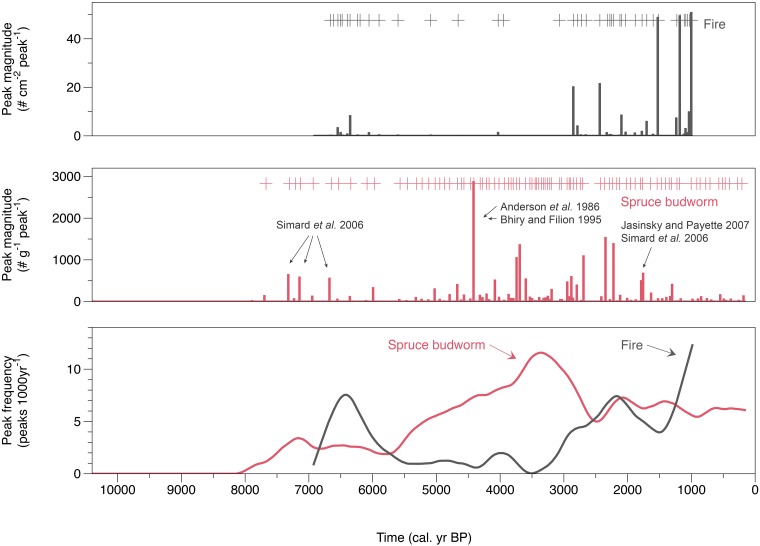
Magnitude of fire (a) and Lepidopteran scale (b) peaks (#·cm-2·peak-1). Each peak exceed the 99th percentile threshold of the residual of Cint-Cback (c) The frequency of fire and SBW (peaks·1000yr-1).